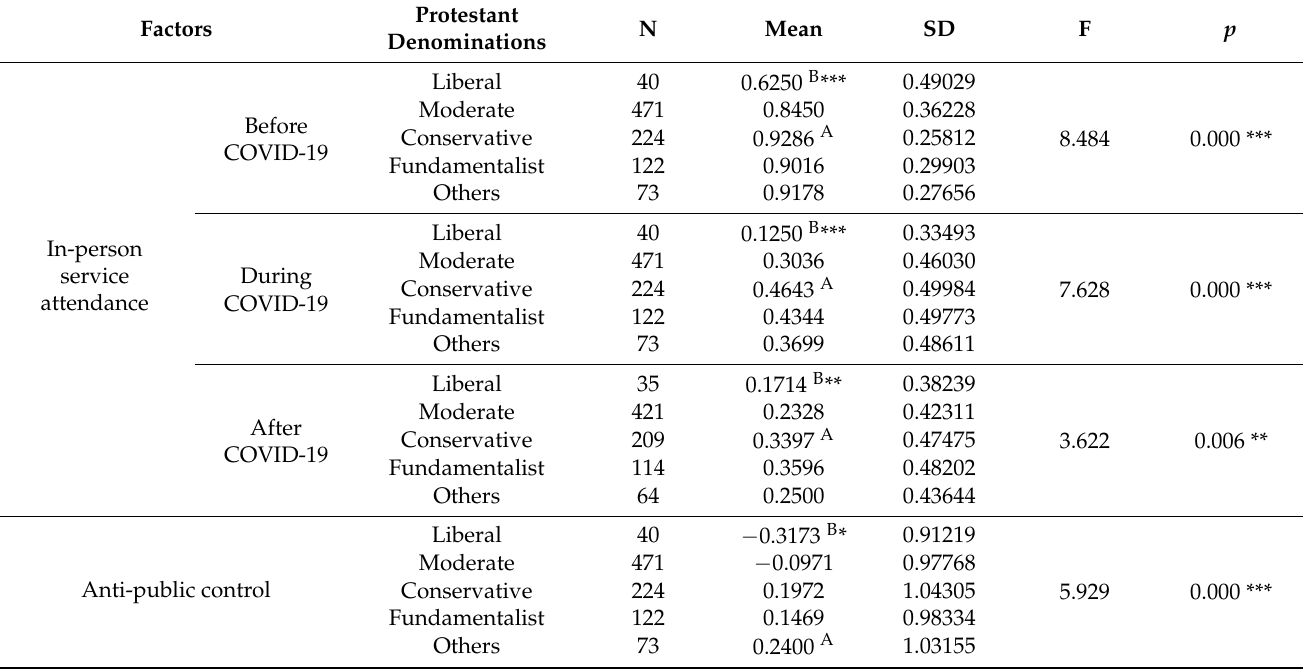
Table 12. One-way ANOVA on dependent variables by